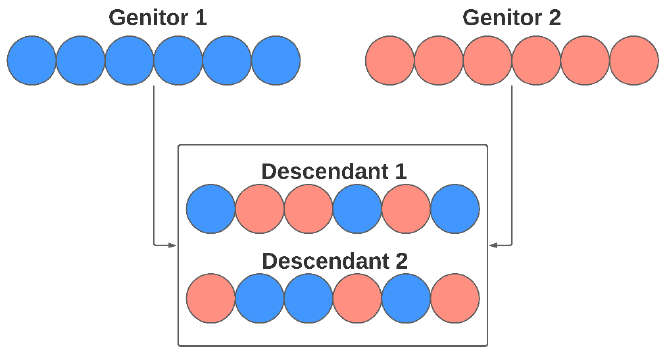
Figure 7. Crossover reproduction in a model selection step.